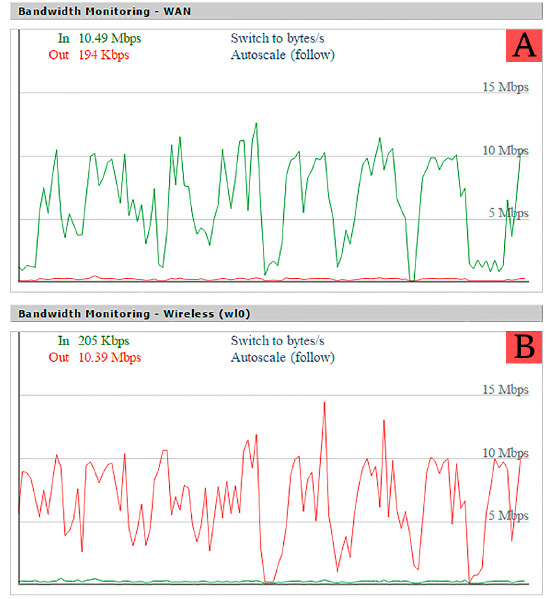
Figure 16. Access point load evolution during the test with heavy load on the Wi-Fi segment. ( A ) Load over wired interface; ( B ) Load over Wireless